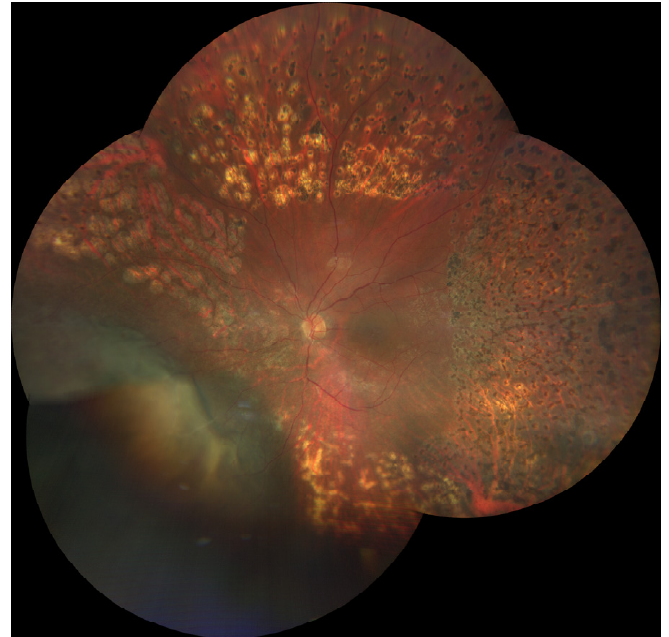
Figure 5. Color fundus photography of a patient treated by panretinal photocoagulation because of radiation retinopathy secondary to brachytherapy for uveal melanoma. The treated uveal melanoma is visible as a pigmented lesion (inferior nasal quadrant).